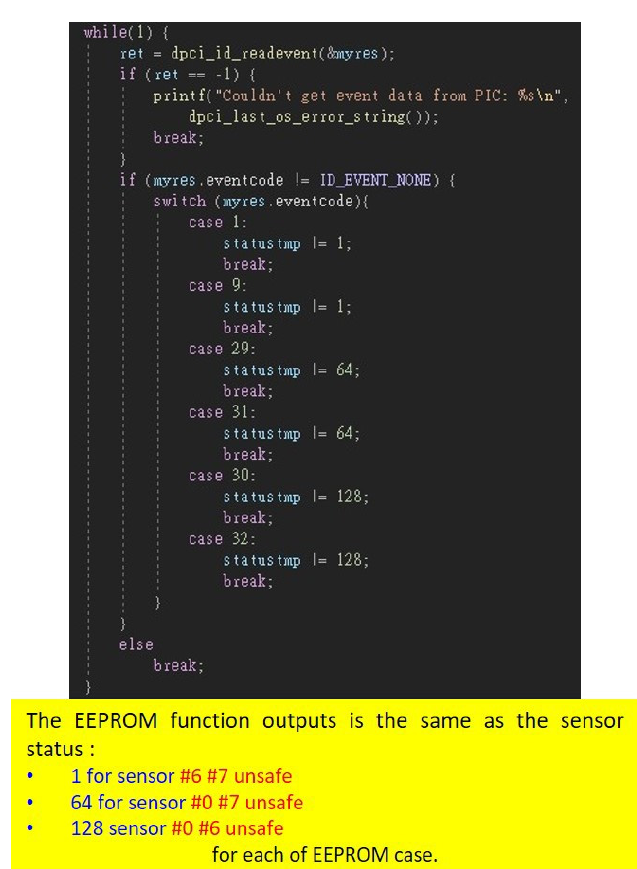
Figure 17. EEPROM function.